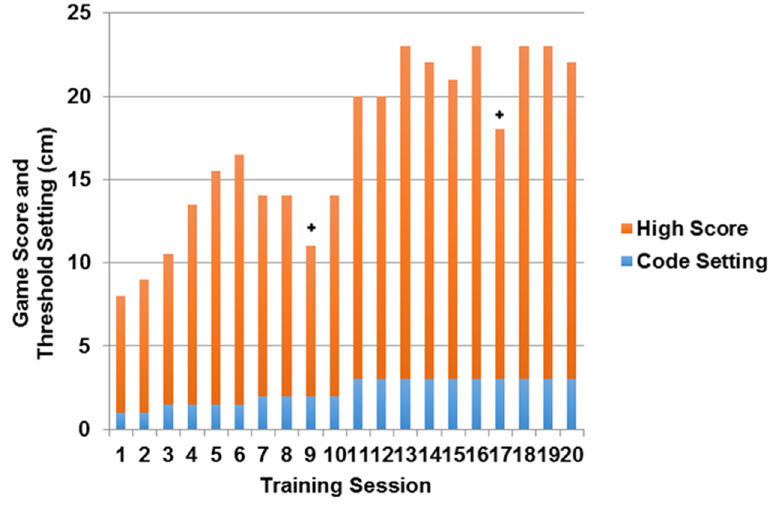
Figure 1. Example of high game score and game success threshold setting over the course of 20 sessions for Participant 1. + Denotes day of technical difficulty that prevented best effort.